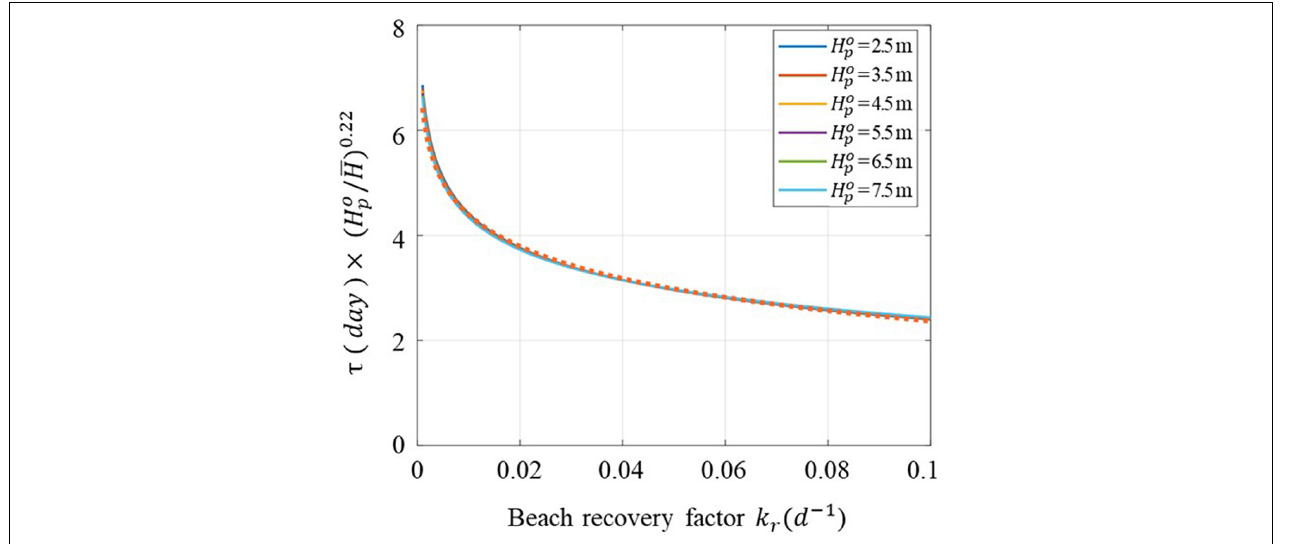
FIGURE 8 | Elapsed time τ from peak wave height to peak erosion width w.r.t the beach recovery factor k r .